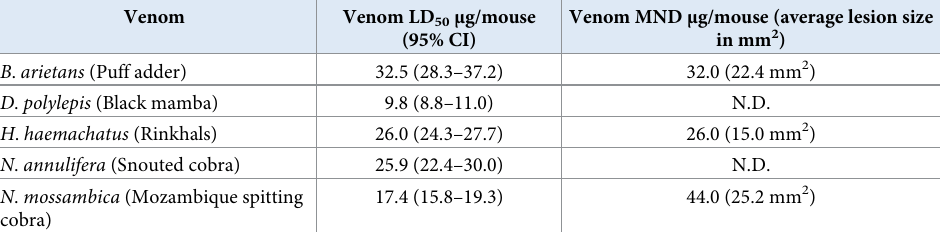
Table 2. Lethal and necrotic toxicity from Eswatini snake venoms in a murine model. The amount of venom that caused lethality in 50% of mice (LD 50 ) following intravenous injection was determined by Probit analyses, and is reported as μ g per mouse, with 95% confidence intervals in parentheses. The minimum amount of venom that caused a lesion approximately 5x5 mm in diameter (MND) following intradermal injection is reported as μ g per mouse, with mean lesion area in parentheses. Due to signs of systemic envenoming at higher doses of H . haemachatus venom injec- tion, a smaller lesion area is reported. N.D. = not determined. All experiments used groups of 5